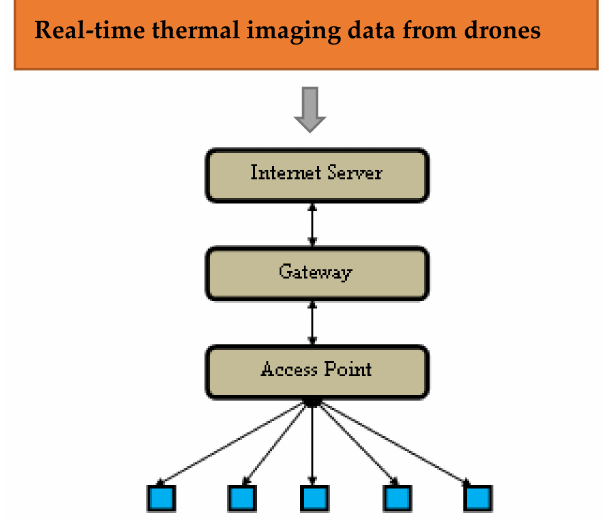
Figure 1. Network